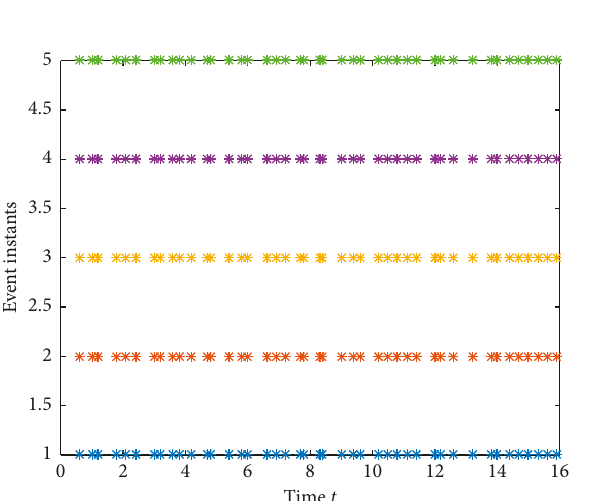
Figure 4: Switching sequence.